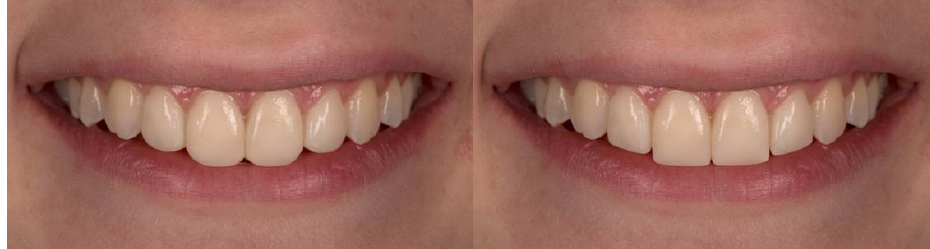
Figure 1. Original image with semi-rounded incisal embrasures, an incisal step of 2 mm, and no diastemas or “black triangles”.